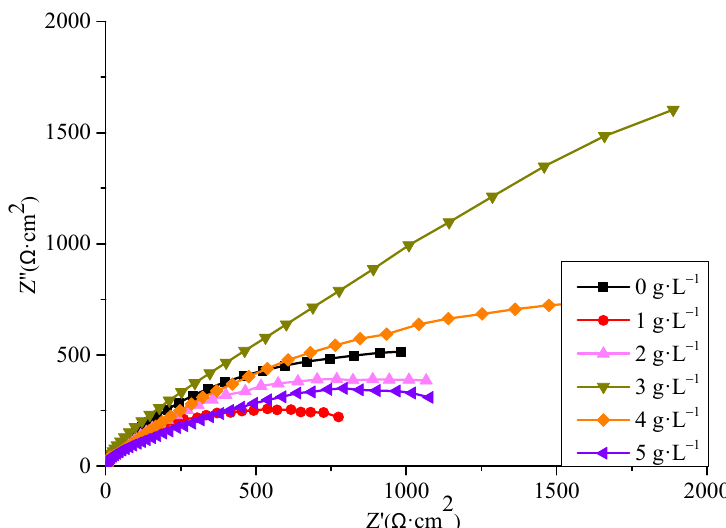
Figure 11. Nyquist plots of coatings with different particle concentrations prepared on 45 steel substrates through scanning electrodeposition.